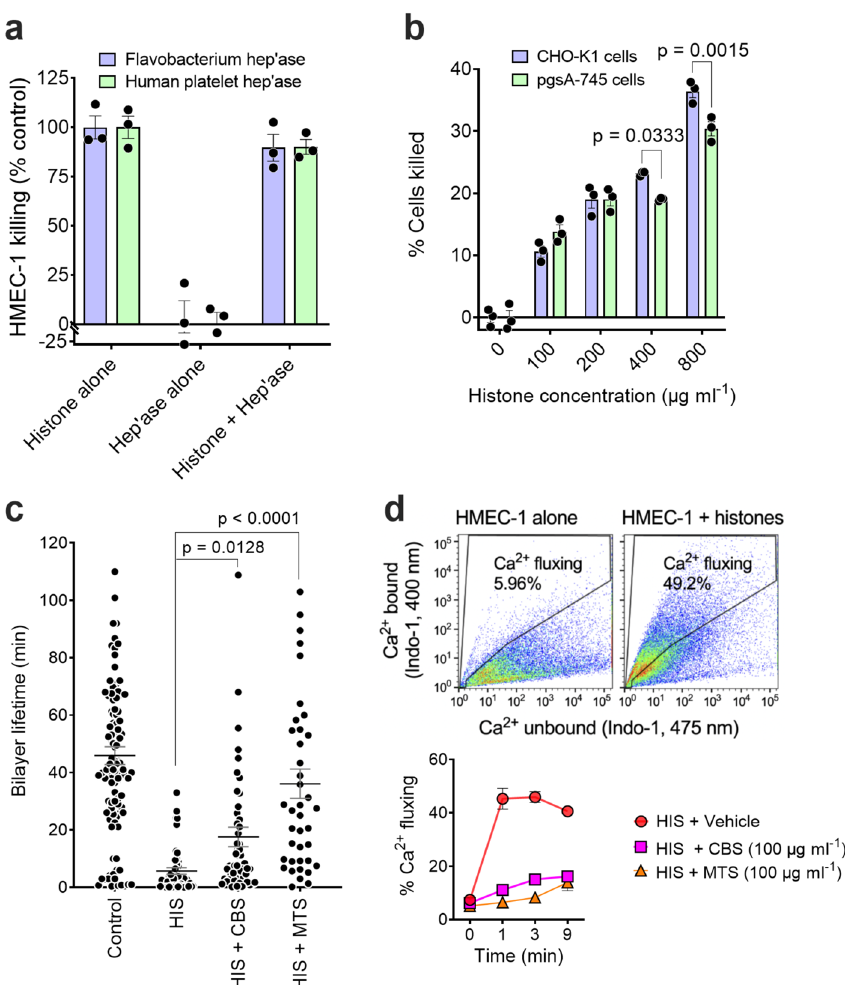
Fig. 3 Histone-mediated cytotoxicity for cells does not require cell surface heparan sulfate, histones directly disrupting lipid bilayers and inducing a cellular Ca 2 + fl ux that can be blocked by SPAs. a Effect of removal of cell surface heparan sulfate by bacterial heparinases 1, 2, and 3 or human platelet heparanase on the sensitivity of HMEC-1 to histone cytotoxicity. b Sensitivity of wild-type CHO-K1 and GAG-de fi cient pgsA-745 CHO-K1 cells to histone cytotoxicity. Data are presented as mean ± s.e.m. ( n = 3) and analyzed by two-way ANOVA with Sidak ’ s multiple comparisons test. c Lifetime of arti fi cial lipid bilayers exposed to histones (HIS) (1 μΜ ) alone ( n = 47) or in the presence of the SPAs CBS ( n = 52) or MTS ( n = 40) (10 μ M). Control bilayers ( n = 125) contained the R γ R1 ion channel protein. Data are presented as mean ± s.e.m. and analyzed by non-parametric Kruskal – Wallis test. d Upper panel: Representative fl ow cytometry plots, using Ca 2 + -sensitive dye Indo-1, showing Ca 2 + fl uxing HMEC-1 1 min following histone addition (100 μ g ml − 1 ). Lower panel: Time course of effect of CBS and MTS (100 μ g ml − 1 ) on histone-induced Ca 2 + fl ux by HMEC-1. Data are presented as mean ± s.e.m. ( n = 2) from one of two experiments. Source data are provided as a Source Data